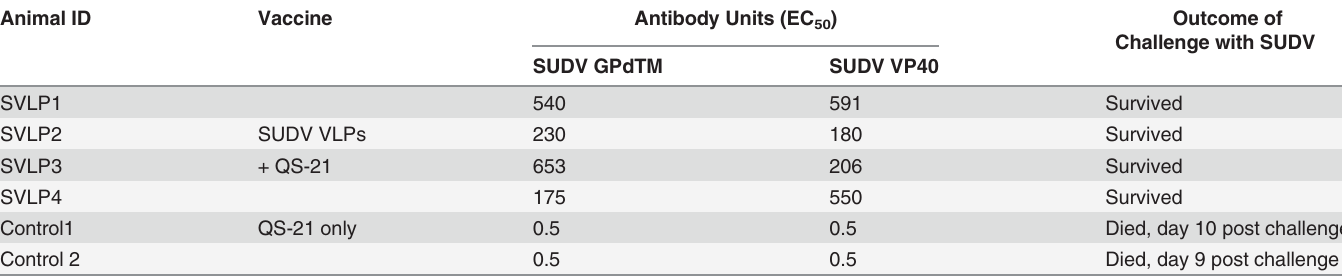
in two of the animals (SVLP1 and SVLP3), while one animal (SVLP4) showed no circulating viral genome copies. Clinical chemistry levels (ex. AST, ALP, ALT, BUN, and Cre) increased in the QS-21 adjuvant only control animals ( Fig. 1D-F and data not shown). Of the vaccinated animals only SVLP2 showed a moderate and transient elevation of ALT, AST, and BUN ( Fig. 1D-F ). During the course of the SUDV infection, the total lymphocyte and platelet counts were significantly decreased in the control animals reaching 50 – 25% of the baseline values be- fore euthanasia (data not shown). Consistent with the observed transient viremia and clinical chemistry findings, SVLP2 also showed decreased lymphocyte counts on days 10 – 15 post chal- lenge. Platelet counts were not significantly decreased in any of the vaccinated animals. Table 2. SUDV VLP vaccine protects cynomolgus macaques from lethal infection with SUDV (Boniface